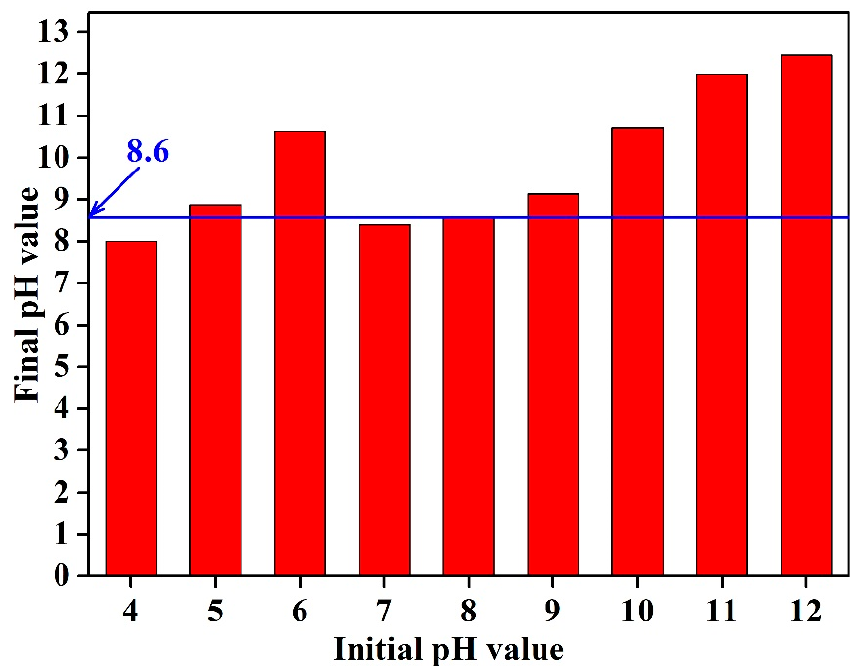
Figure 4. The effect of the initial solution pH value on final solution pH value. Figure 4. The e ff ect of the initial solution pH value on final solution pH